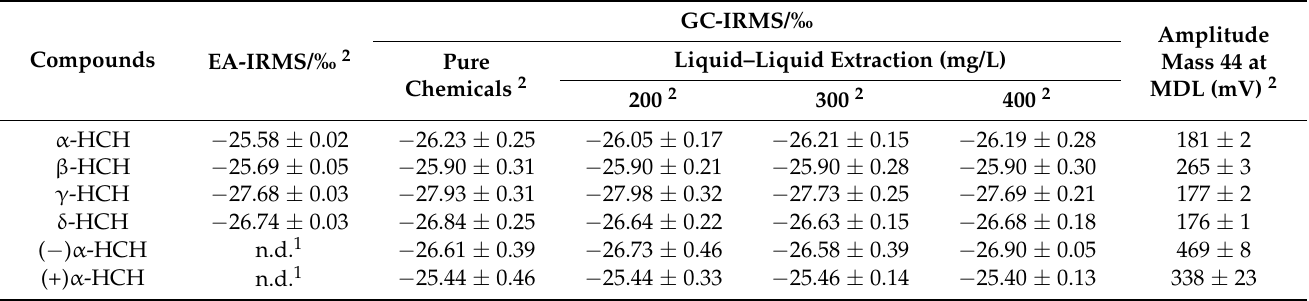
Figure 1. The fitting curve between measured and true values of the isotopic reference materials. Table 2. Comparison between EA-IRMS and GC-IRMS for HCHs, α -HCH enantiomers, respectively and the MDLs of HCHs, after liquid–liquid